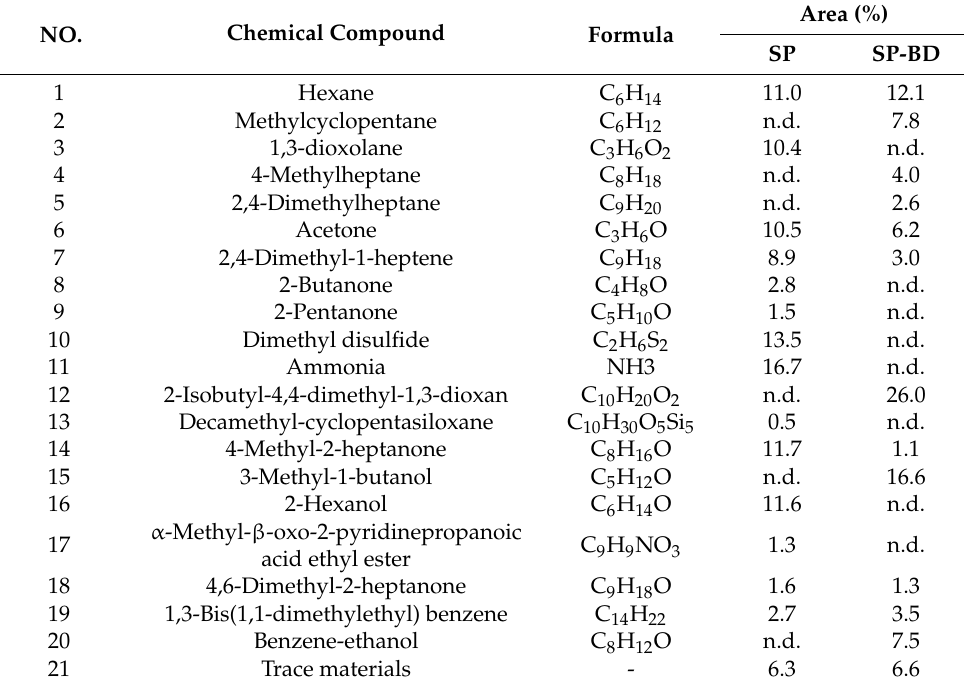
Table 4. Determination and identification of volatile compounds in the fermented placenta via SPME-GC